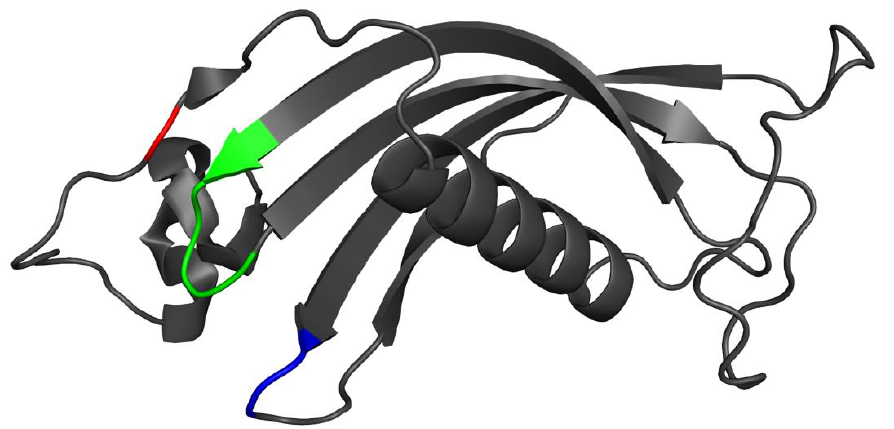
Figure 7. The tertiary structure of cystatin C of Danio rerio in gray with the N-terminal glycine residue in red, the QVVAG motif in green, and the PW motif in blue.